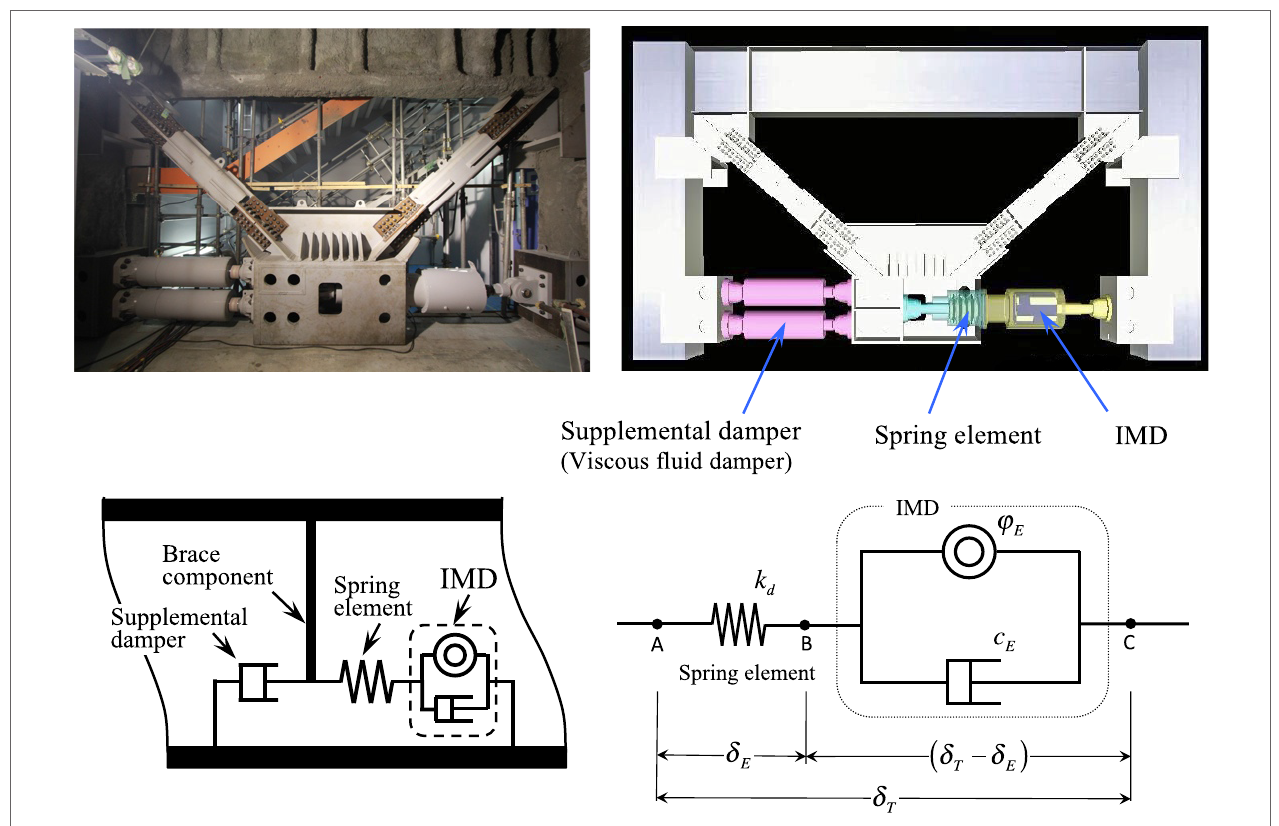
FIGURE 4 | Photograph, configuration and mechanical model of standard tuned inertial mass damper (T-IMD)